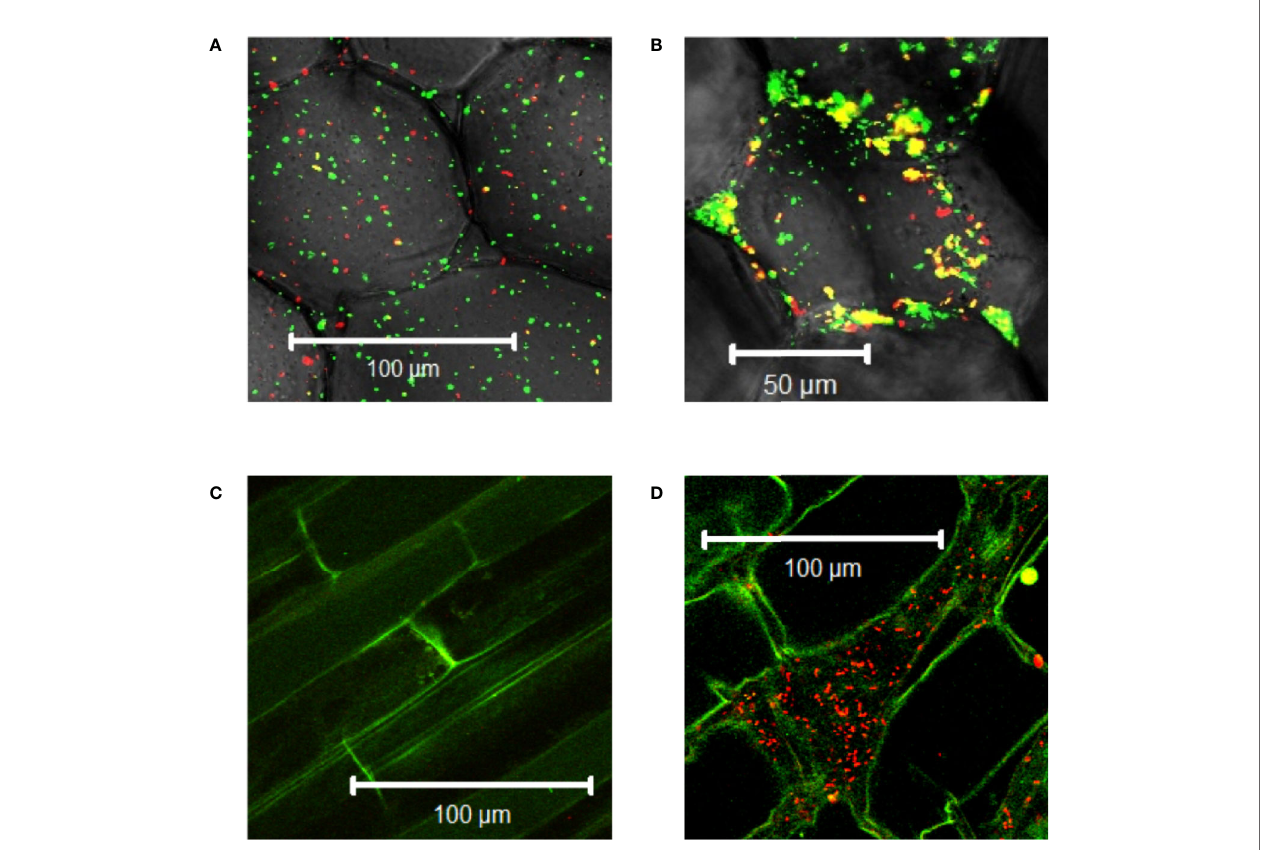
FIGURE 2 | Agrobacterium cells colonizing plants localize to the apoplast. YHL324 s+ colonizing the pith tissue of tobacco stem explants on the surface (A) or 60 µm below the surface (B) . Unfortunately, co-expression of both markers was not uniform in the absence of selection, limiting quantitative assessment. Nevertheless, unwounded (C) and wounded (D) tobacco seedlings co-cultivated with AB650 wt reveal distinct bacterial colonization in the wounded plant. The cells walls of the tobacco seedlings auto- fl uoresce, allowing for clear delineation of plant cell